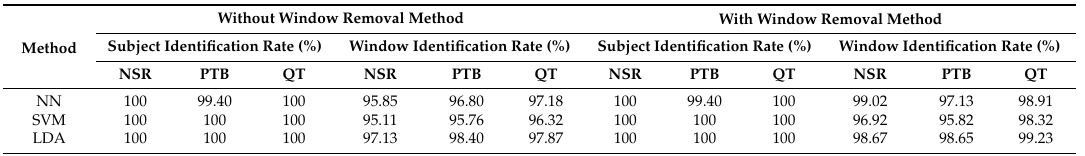
Table 6. Comparison of the results with and without the window removal